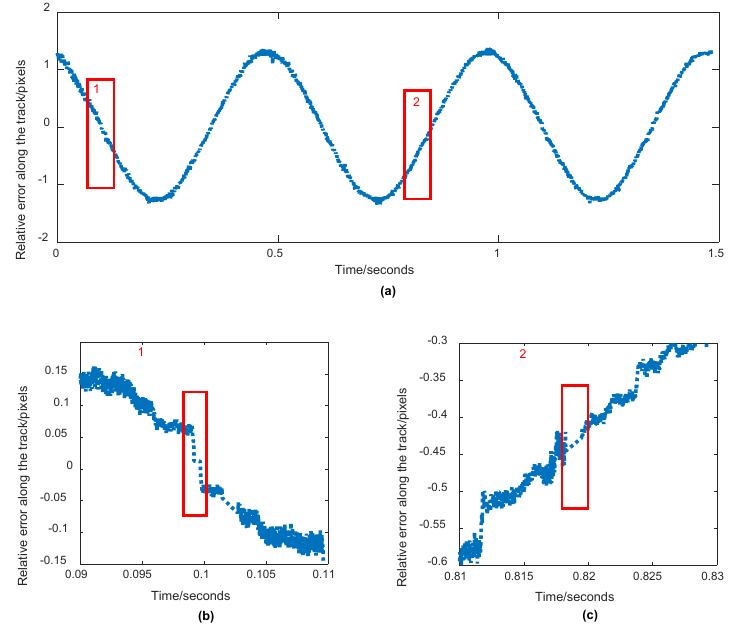
Figure 13. The 2-Hz jitter detection curves by sequential disparity maps after interpolation. ( a ): The whole detected results after interpolation; ( b ): the local amplification of rectangular area 1 in ( a ); ( c ): the local amplification of rectangular area 2 in ( a ).